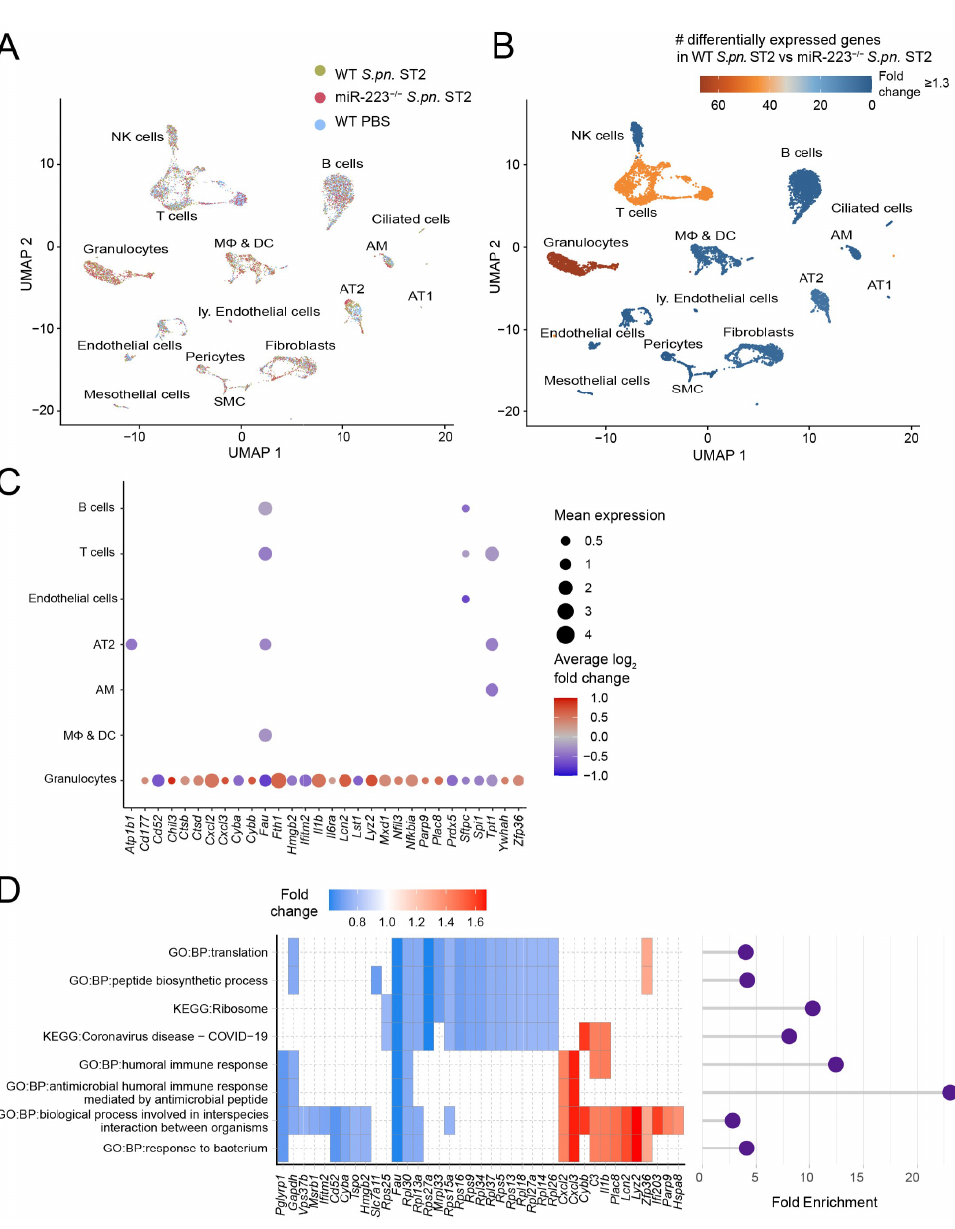
Figure 5. scRNA-seq of murine lungs 24h following S.pn. ST2 infection. ( A ) UMAP plot of identified cell populations in the lungs of WT and miR-223 − / − mice following S.pn. ST2 (WT, miR-223 − / − ; n = 3) or sham (PBS Ctrl, WT; n = 2) infection. ( B ) Number of significant differentially expressed genes (minimum fold change 1.3) in miR-223 − / − mice (relative to WT mice) infected with S.pn. ( C ) Dot plot of significantly differentially expressed genes involved in inflammation, granulocyte maturation, enzymatic digestion and antibacterial defense in WT versus miR-223 − / − mice. ( D ) Pathway enrich- ment analysis of miR-223 − / − versus WT lung cells sequenced following S.pn. infection. Coloration and point sizes indicate log 2 -transformed fold changes and mean expression levels, respectively. AT1: alveolar epithelial cells type I, AT2: alveolar epithelial cells type II, AM: alveolar macrophages, SMC: smooth muscle cells, M Φ & DC: interstitial and inflammatory macrophages/monocytes and dendritic cells, ly. Endothelial cells: lymphatic endothelial cells, NK cells: natural killer cells, GO:BP: Gene Ontology:Biological Process, KEGG: Kyoto Encyclopedia of Genes and Genomes, UMAP: uniform manifold approximation and